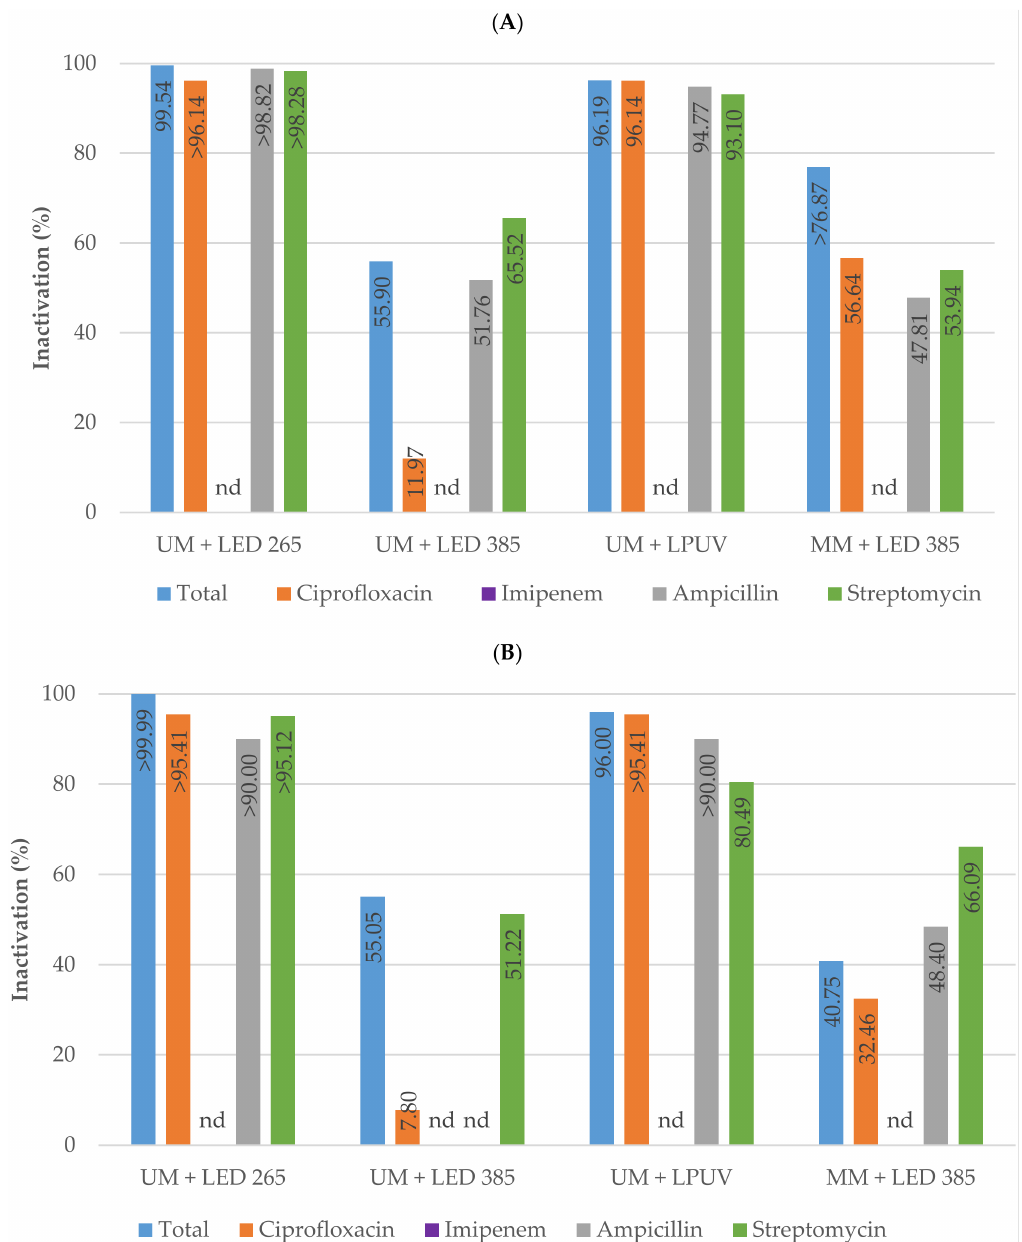
Figure 6. Percentage inactivation using various light sources of total coliforms and antibiotic-resistant total coliforms ( A ) as well as Escherichia coli and antibiotic-resistant Escherichia coli ( B ) adsorbed by the membranes after washing the unmodified (UM) and modified membranes (MM). The antibiotics tested were ciprofloxacin, imipenem, ampicillin, and streptomycin. Columns marked “nd” indicate that the target microorganisms were not detected in the untreated surface water samples. Columns marked “>” indicate that the target microorganisms were not detected in the treated water